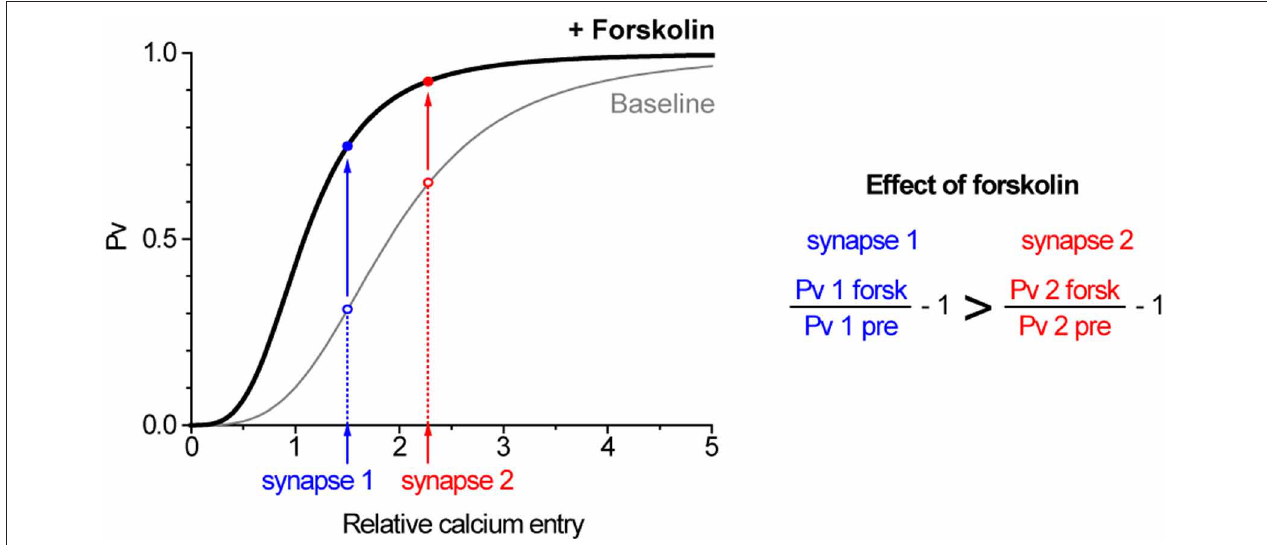
FIGURE 10 | A simple model can explain how forskolin has a greater effect on synapses with lower Pv . The graph illustrates two synapses with differing Ca 2 + entry in response to single AP (synapse 2 > synapse 1) in which primed vesicles have the same fusogenicity (gray curve). When forskolin is applied, the fusogenicity of primed vesicles increases equally in both synapses (black curve, shifted left)